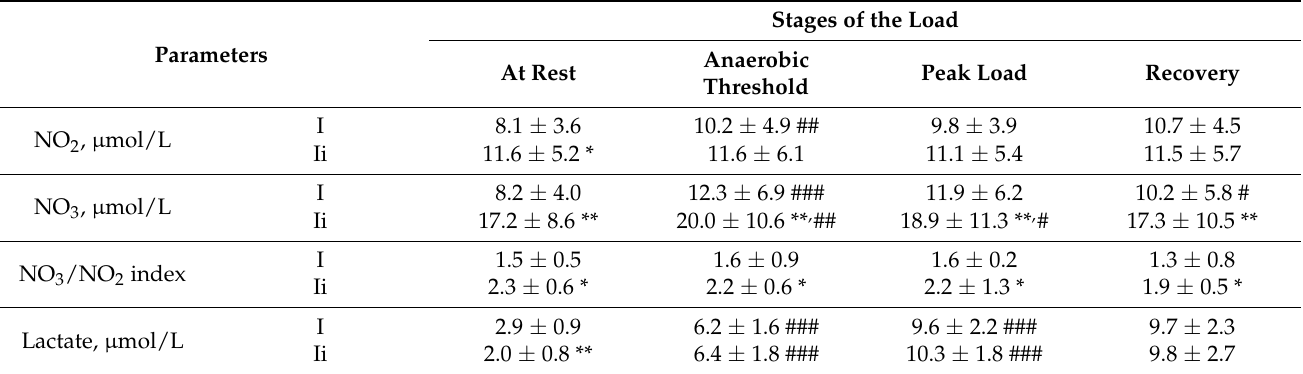
Table 3. Nitric oxide and lactate levels at different stages of the load in cross-country skiers, ME ± SD.